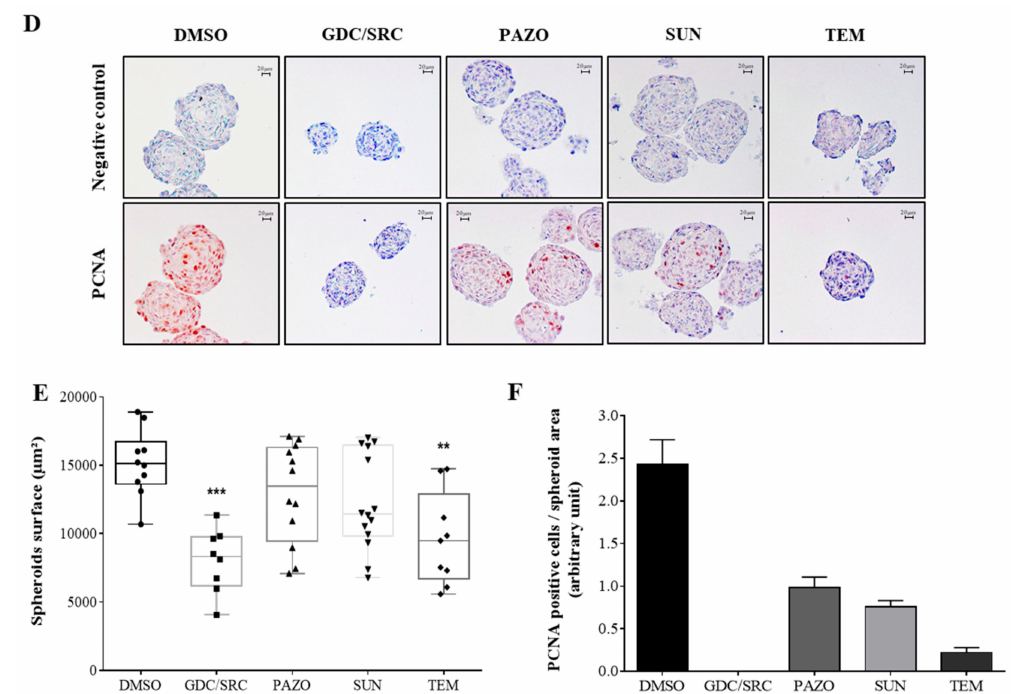
Figure 1. Treatment of 786-O spheroids. 786-O-WT (VHL - ) cells were grown as spheroids and treated with 10 µ M of either GDC-0941 + saracatinib (10 µ M each, GDC / SRC, (cid:78) ), pazopanib (PAZO, (SUN, (cid:7) ), temsirolimus (TEM, (cid:8) ), or vehicle (DMSO, (cid:4) ) in the presence of propidium iodide. Cell death was monitored on spheroids using either an Essen IncuCyte Zoom live-cell microscopy incubator or by immunohistochemistry. ( A ) Bright field and fluorescent overlaid images show 786-O-treated spheroids at indicated times (0, 6, 12, 24, and 48 h). Bar scale 300 µ m. ( B ) Images taken automatically every 6 h over 48 h of culture were analyzed for PI fluorescent area quantification. Cell death values (PI labeling area) was divided by the corresponding spheroid area and multiplied by 100. This percentage of cell death was divided by the one at T 0 , for all the others time points and was expressed as mean ± SEM. The statistical analysis of dead cells was performed with 2 way ANOVA test for each time point compared to DMSO treatment. ( C ) The same images were analyzed for spheroid area quantification. Significant di ff erence was observed between GDC / SRC (**** p ≤ 0.001), SUN (**** p ≤ 0.01), TEM (**** p ≤ 0.01) versus DMSO after 36 h of treatment using a Kruskal-Wallis test. ( D ) PCNA staining to visualize proliferation of fixed para ffi n-embedded (scale bar, 20 µ m). ( E ) Spheroid area quantification by surface calculation of ( D ), ( n ≥ 8). Significant di ff erence was observed between GDC / SRC (*** p ≤ 0.001), TEM (** p ≤ 0.01) versus DMSO in a Kruskal-Wallis test. ( F ) The number of PCNA positive cells was quantified in each spheroid and divided by the corresponding spheroid surface. Histogram plot represents mean of PCNA-stained cells pooled from 4 to 6 spheroids (biological replicated / condition) with error bar ( ±